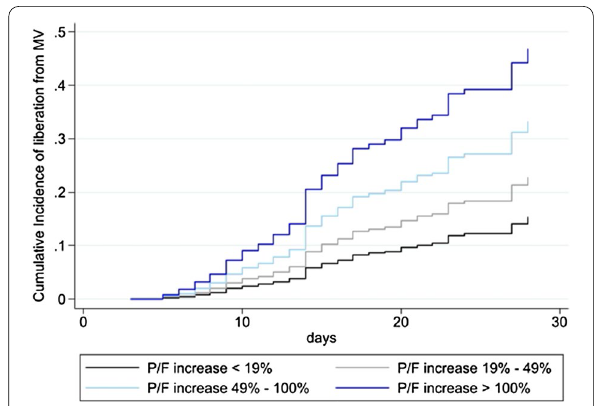
Fig. 2 Cumulative incidence of liberation from mechanical ventilation. Cumulative incidence of liberation from mechanical ventilation (MV) over 28 days after intubation. The four curves represent the cumulative incidence functions related to the quartiles of PaO 2 /FiO 2 response to prone positioning referred to the multivariate model (Table